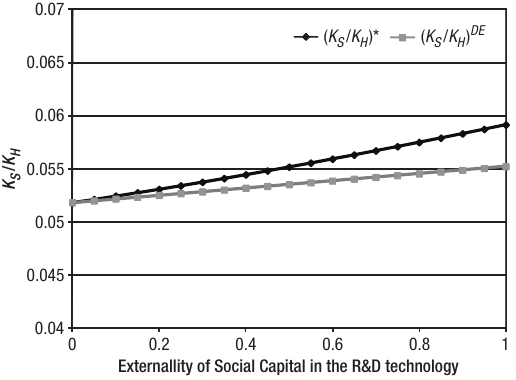
Fig. 4. Comparison between ( K